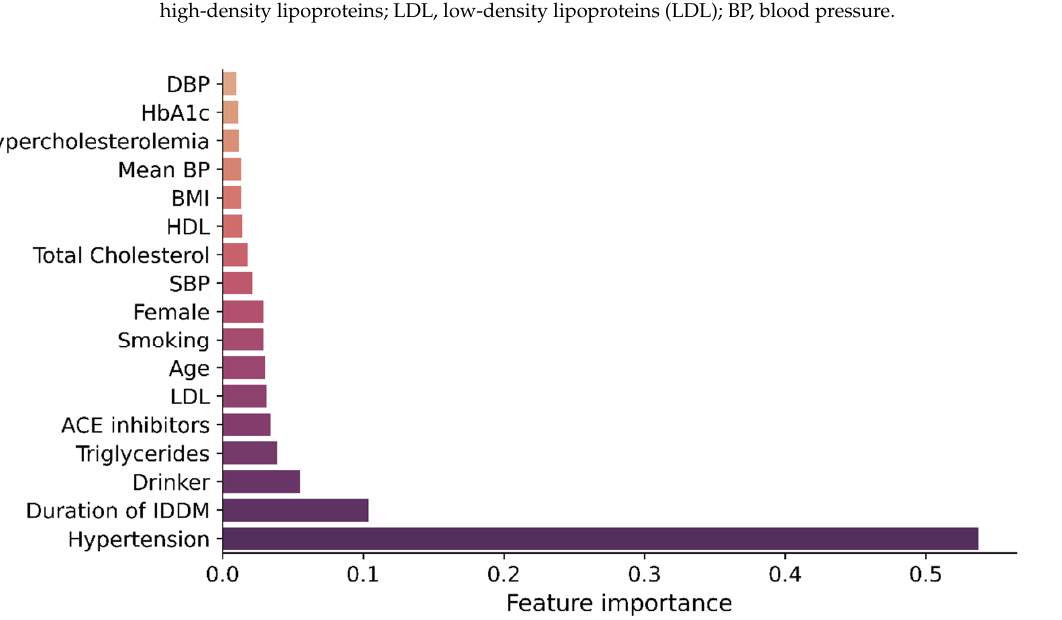
Figure 2. Feature ranking using XGB algorithm.